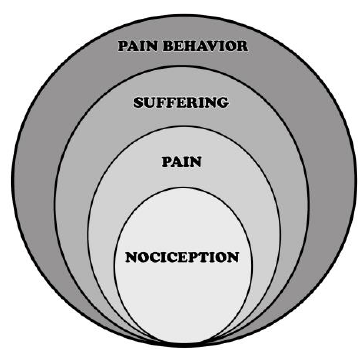
Figure 1. Loeser’s onion model displaying the four components of pain phenomena. Reprinted from Loeser, J.D. Pain as a Disease [29].